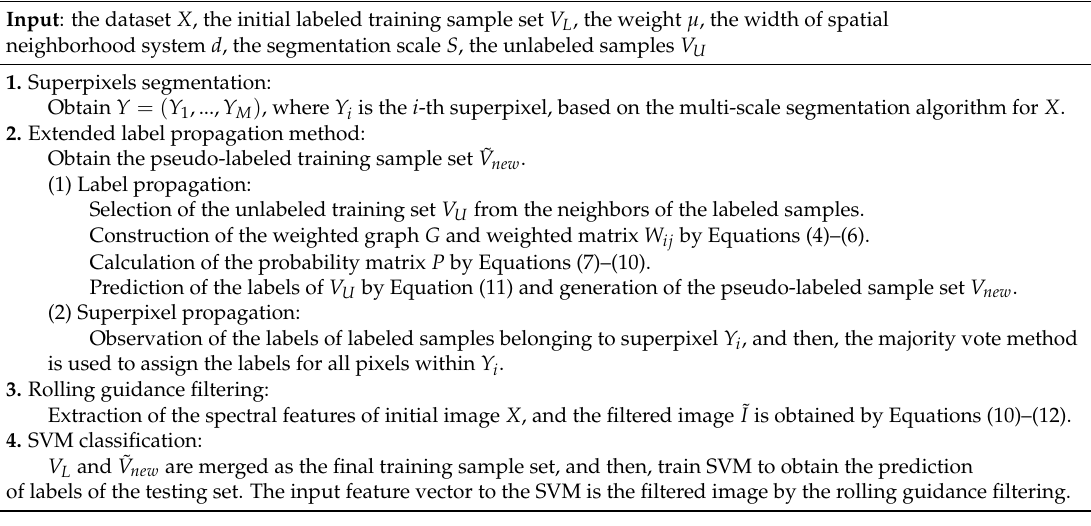
Algorithm 1: proposed ELP-RGF